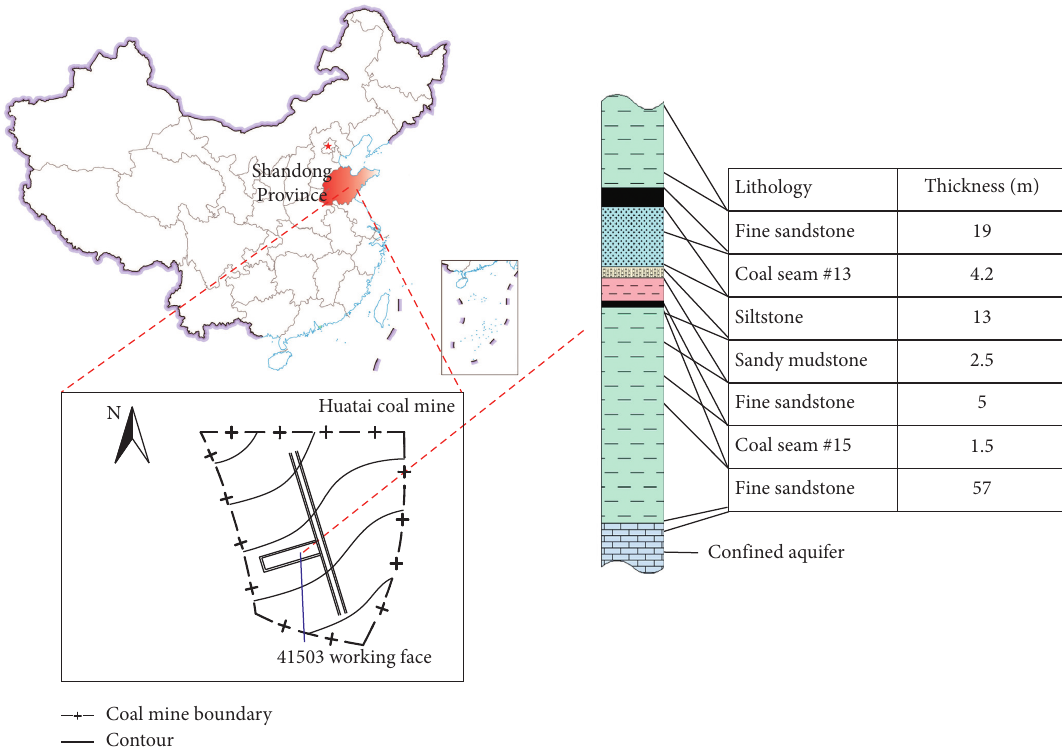
Figure 1: Location of Huatai coal mine and comprehensive histograms of strata.